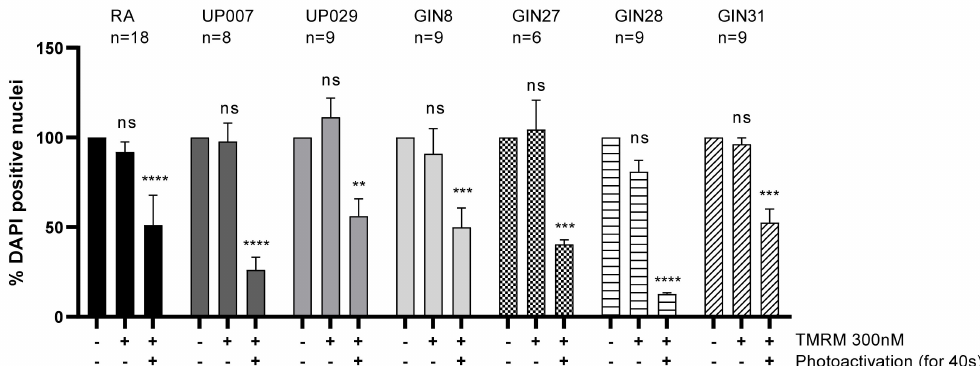
Figure 3. Three days after TMRM-PDT (300 nM; 40 s; 1.06 mW/mm 2 ), density of cells was reduced. N is the total number of repeats from 7 independent experiments for RA, 2 for GIN27 and 3 for the other GBM cells. (**) p value < 0.003, (***) p value < 0.001, (****) p value < 0.0001. ns—not significant.